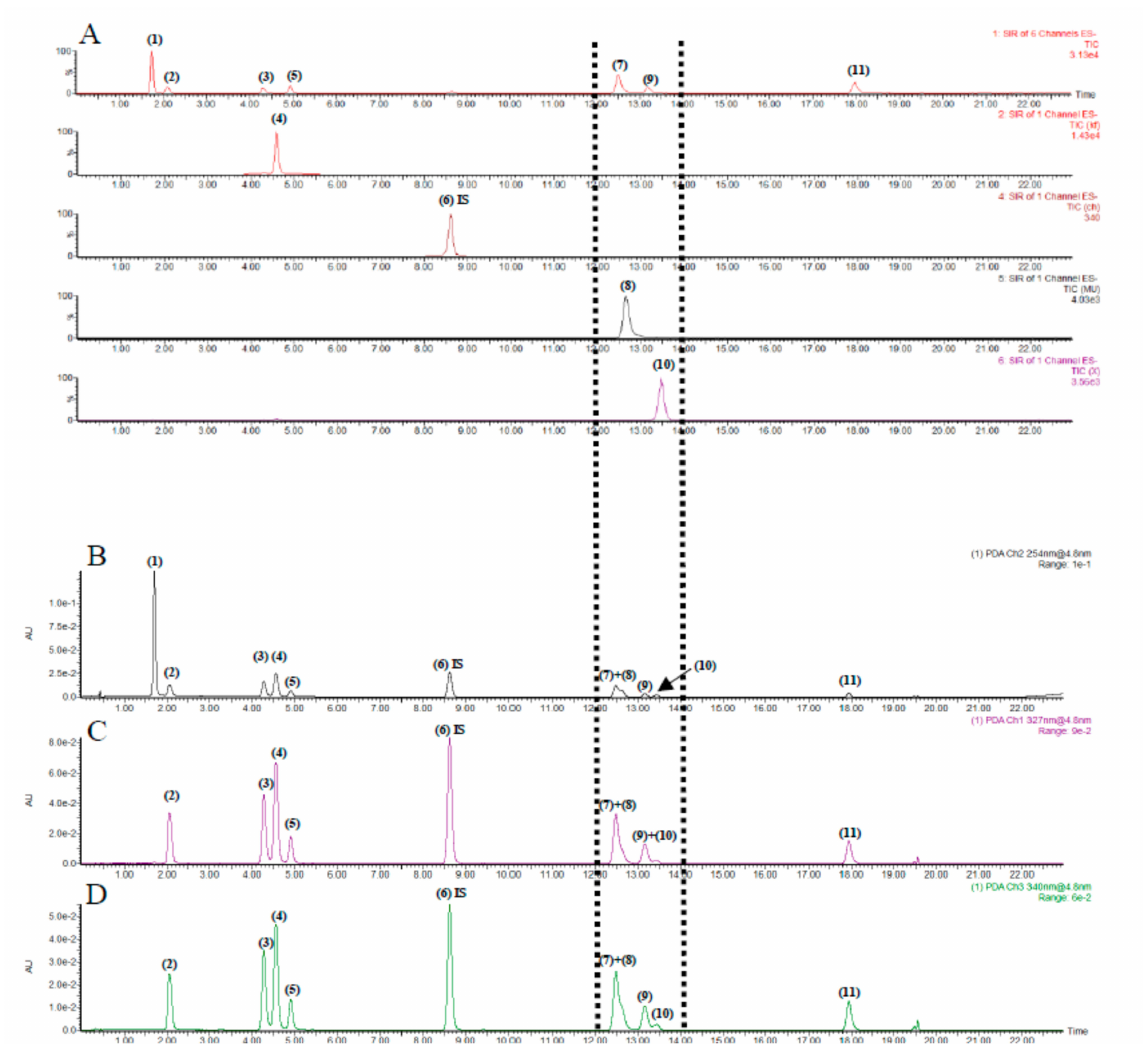
Figure 3. ( A ) Representative extraction ion chromatograms of the samples with IS and chromatograms of samples with IS determined at di ff erent wavelengths of ( B ) 254, ( C ) 327, and ( D ) 340 nm. The mixed reference standards of ( 1 ) 3,4-dihydroxybenzoic acid, ( 2 ) 5-O-ca ff eoylquinic acid, ( 3 ) 3-O-ca ff eoylquinic acid, ( 4 ) ca ff eic acid, ( 5 ) 4- O -ca ff eoylquinic acid, ( 6 ) IS (chloramphenicol), ( 7 ) 3,5- O -di-ca ff eoylquinic acid, ( 8 ) luteoloside, ( 10 ) rutin, ( 9 ) 3,4- O -di-ca ff eoylquinic acid, and ( 11 ) 4,5- O -di-ca ff eoylquinic